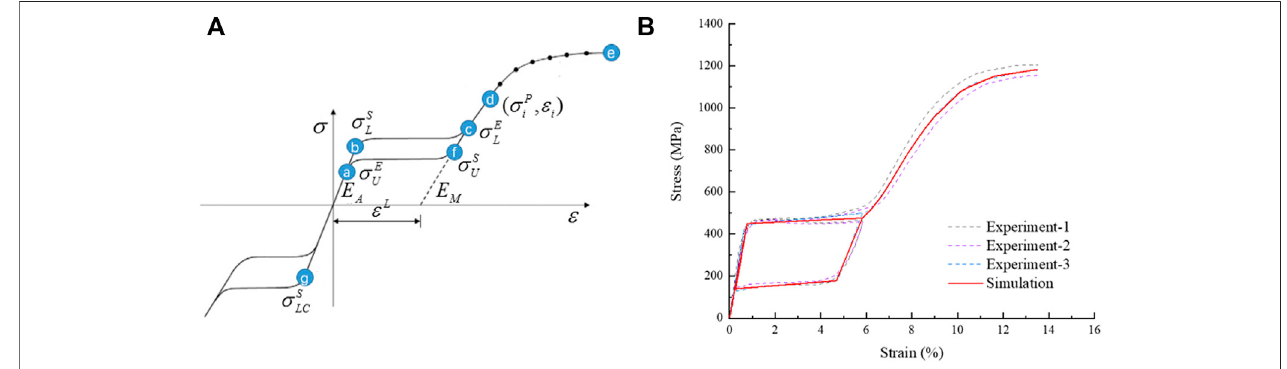
FIGURE 5 | Schematic diagram of NiTi material properties, (A) the tensile strain-stress curve of the material and (B) the stress-strain curve fi tted by simulation analysis.